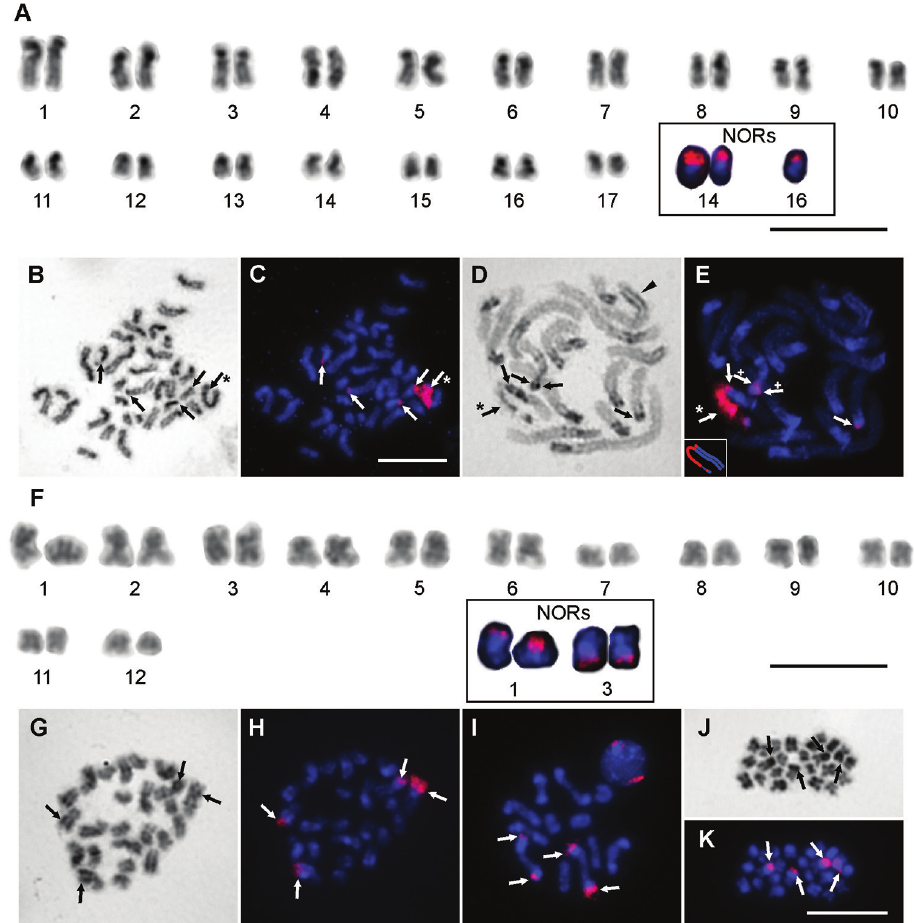
Figure 2. Chromosomes of Rhampsinitus capensis (2n=34) ( A-E ) and Rhampsinitus discolor ( F–K ) (2n=24) after Giemsa staining ( A, B, D, F, G, J ) and after FISH with 18S rDNA ( A and F partly, C, E, H, I, K ). A male karyotype based on mitotic metaphase B, C female mitotic metaphase D, E female pachytene, bottom left inset shows a reconstruction of the heteromorphic bivalent; crosses indicate the subterminal position of 18S rDNA; arrowhead indicates bivalent with the expanded positive heterop- ycnotic area F male karyotype based on two sister cells of metaphase II G, H male mitotic metaphase I diakinesis J, K two sister cells of metaphase II. White arrows indicate the position of 18S rDNA and black arrows indicate the position after Giemsa staining. Asterisks indicate large signal of heteromorphic bivalent. Bar = 10